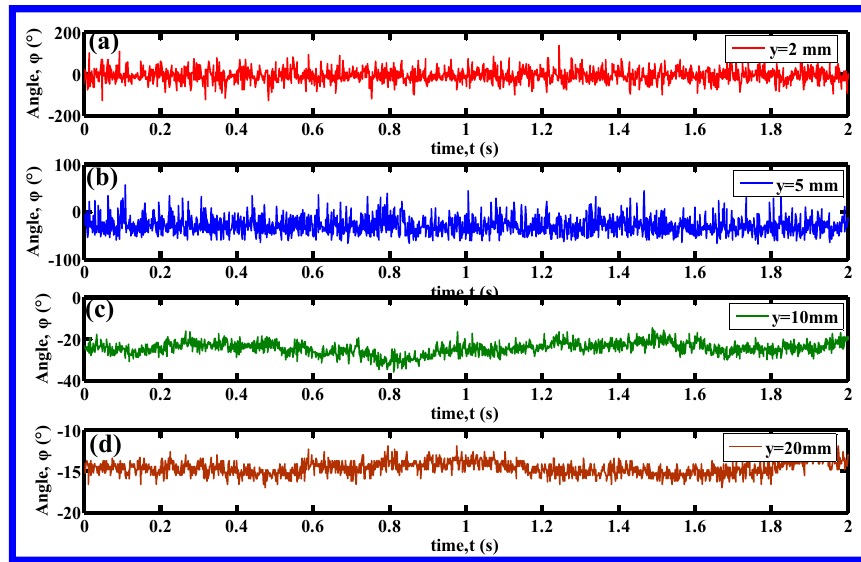
Figure 8. The fluctuant signals of the angle between the z -axis and the resultant velocity in the y–z plane at the ( y , z ) positions of ( a ) (2 mm, 6 mm), ( b ) (5 mm, 6 mm), ( c ) (10 mm, 6 mm), ( d ) (20 mm, 6 mm).